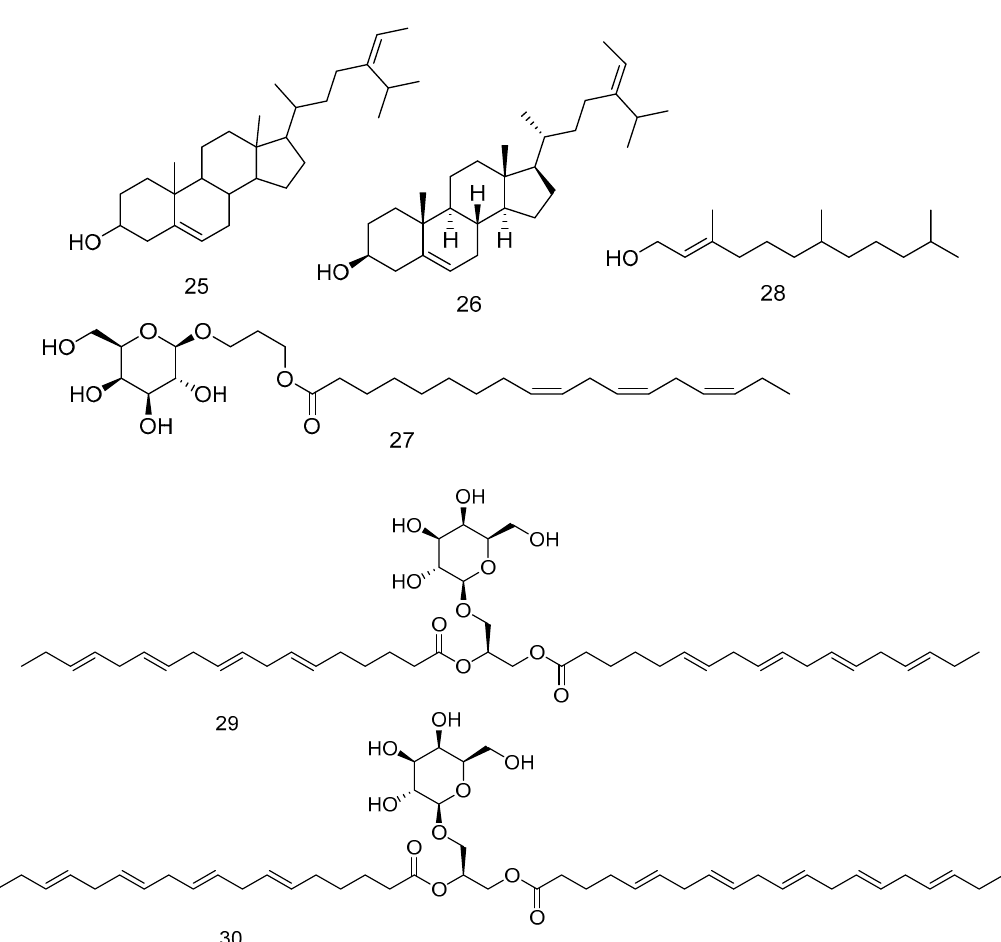
Figure 8. Compounds from 25 – 28 (phytosterols, glycolipid, and farnesol) and compounds 29 and 30 (Diacylglyceroglycolipids).